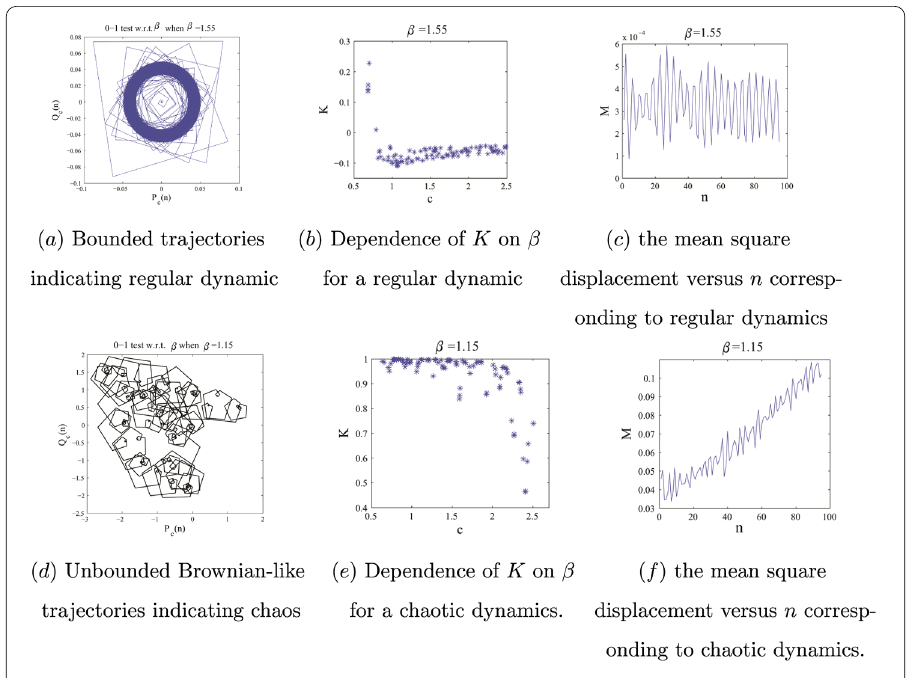
Figure 5 The 0-1 test for detecting